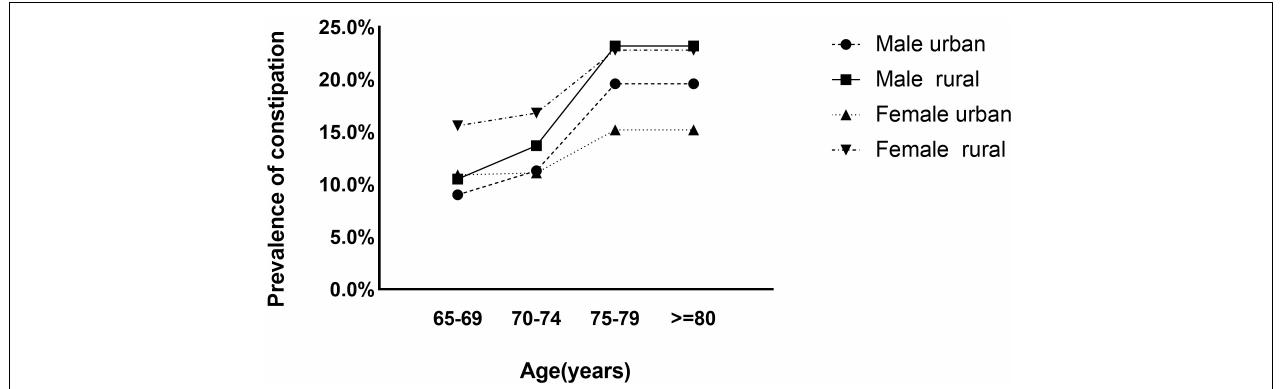
FIGURE 2 | Prevalence of constipation by age and sex categories in urban and rural populations.